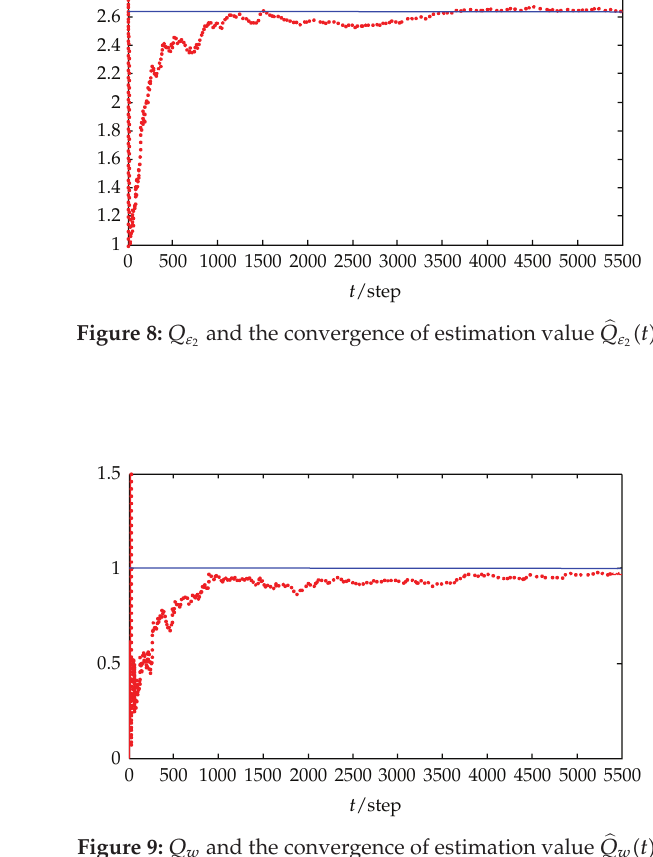
Figure 9: Q w and the convergence of estimation value